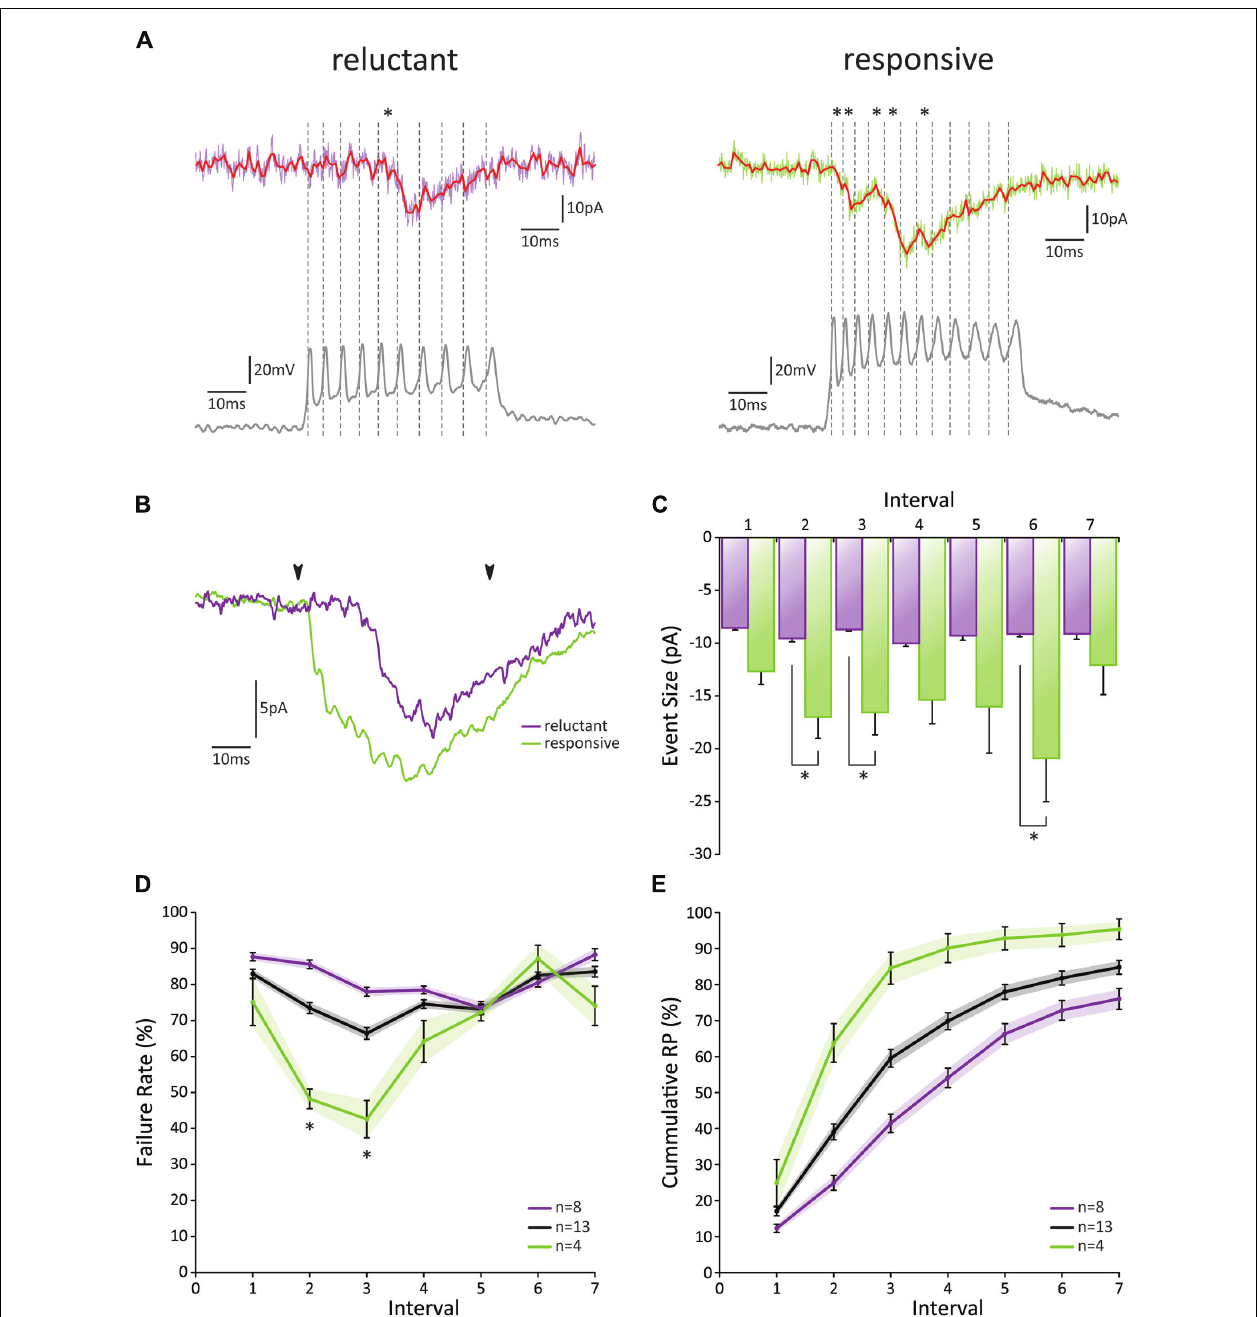
FIGURE 4 | Paired GrC-PC recordings reveal heterogeneity in PF release probability. (A) Examples of paired recordings. Based on the cumulative release probability over the first three spikes, pairs could be subdivided into a “reluctant” group (left) and “responsive” group (right). (top traces) Original voltage clamp recordings from PCs (purple and green for “reluctant” and “responsive” connections, respectively) and their processed signals used for analysis (red); asterisks indicate detected events. (bottom traces) Current clamp recordings from GrCs. Spiking is induced via current injection. Dashed lines indicate detected spikes. (B) Averaged responses over all recordings from cells shown in A. Beginning and end of current injections are indicated by arrowheads. Note a faster overall response in the responsive connection (green). (C) EPSC amplitudes did not change in size during the burst for